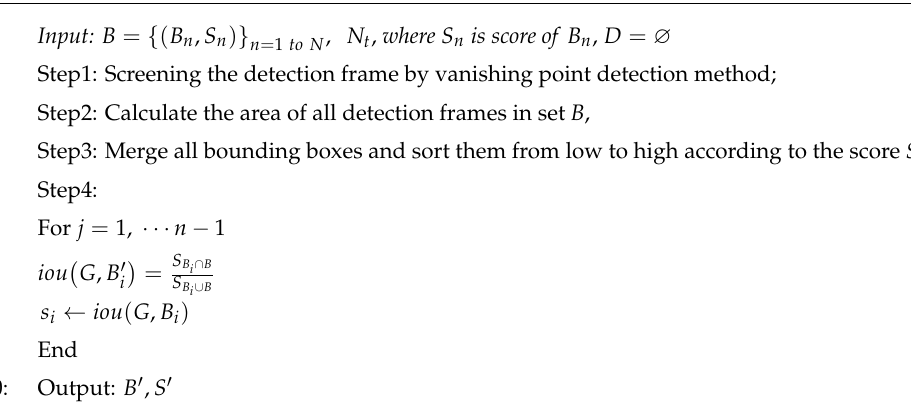
Figure 5. Architectural of AVOD sensor fusion network. Algorithm 1 : Pseudo codes for Gaussian weighting NMS